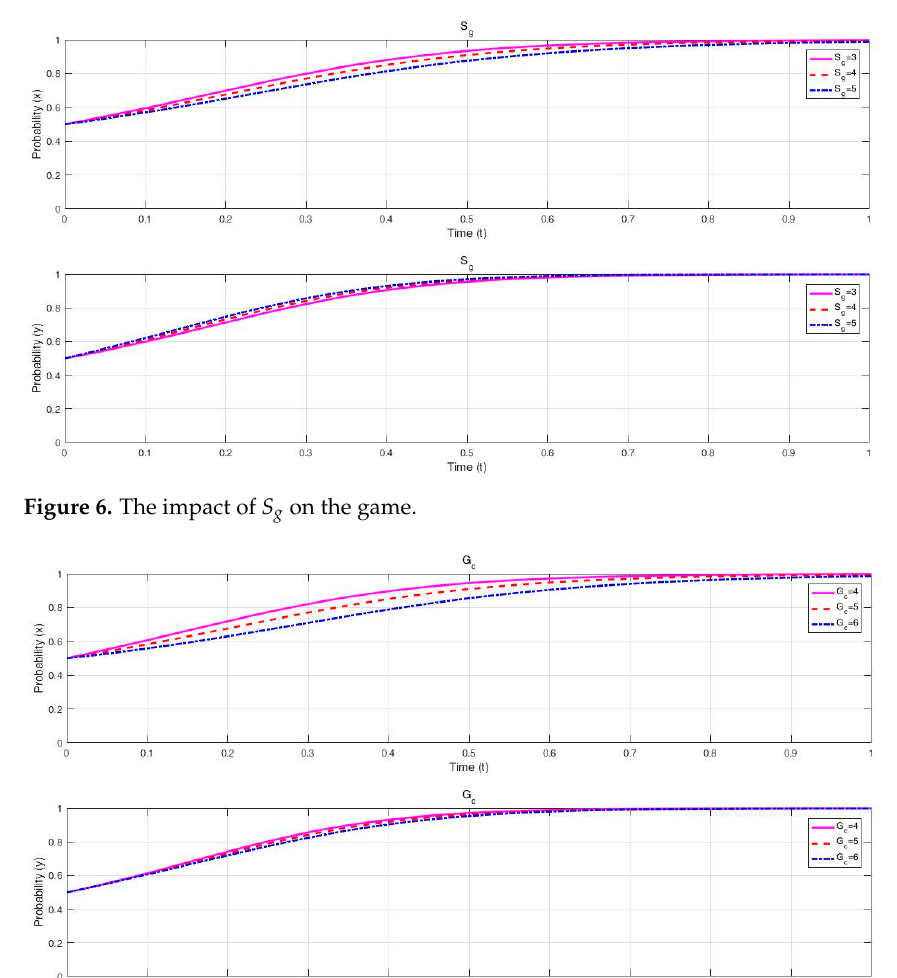
Figure 5. The impact of E r on the game.